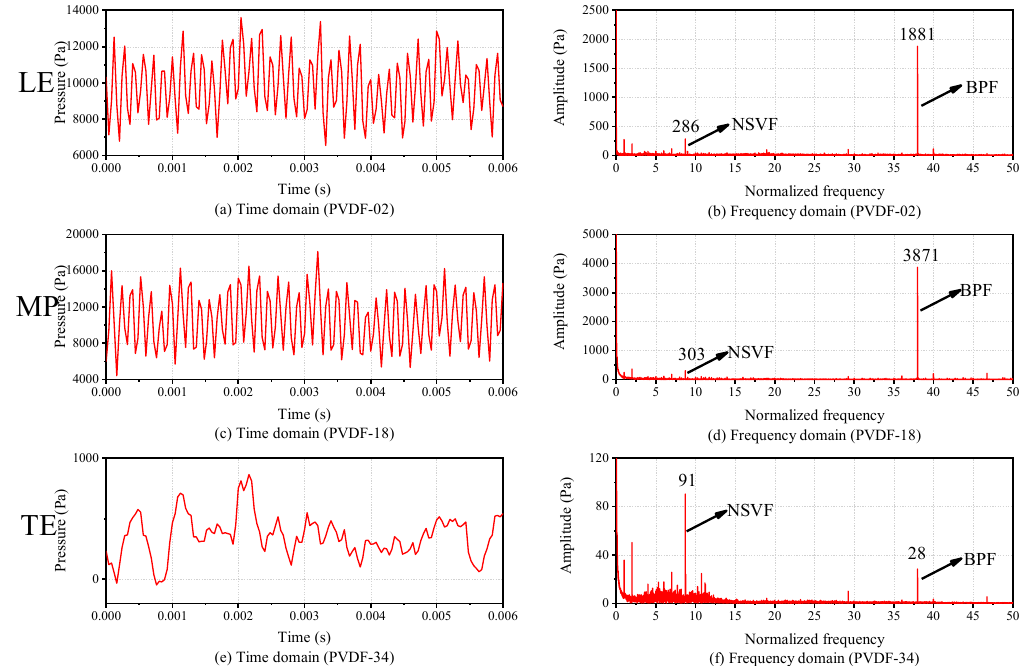
Sensors 2019 , 19 , x FOR PEER REVIEW Figure 19. Time domain and frequency domain comparison in the axial direction (NSV state).